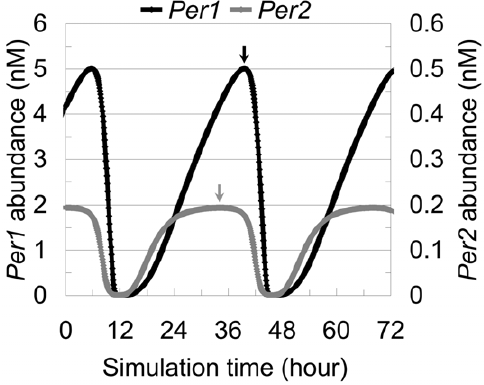
Figure 3. Measured synthesis and degradation rates do not reproduce the phase relationship between Per1 and Per2 . A simulation result of Per1 and Per2 mRNA expressions calculated by the model schematized in Figure 1A with the ratio of both transcription and degradation rates measured experimentally and applied as parameters. This model simulated the circadian oscillations in 33.8- hour period. After 1000 hours simulation, the first peak of Per1 mRNA was set to simulation time 6. The Per2 expression level was almost 25 times lower than that of Per1 even though its corresponding transcriptional rate was just one-third of the original value, and the Per2 phase was advanced by 5.4 hours, which was inconsistent with the experimentally observed results. Arrows indicate expression peaks.